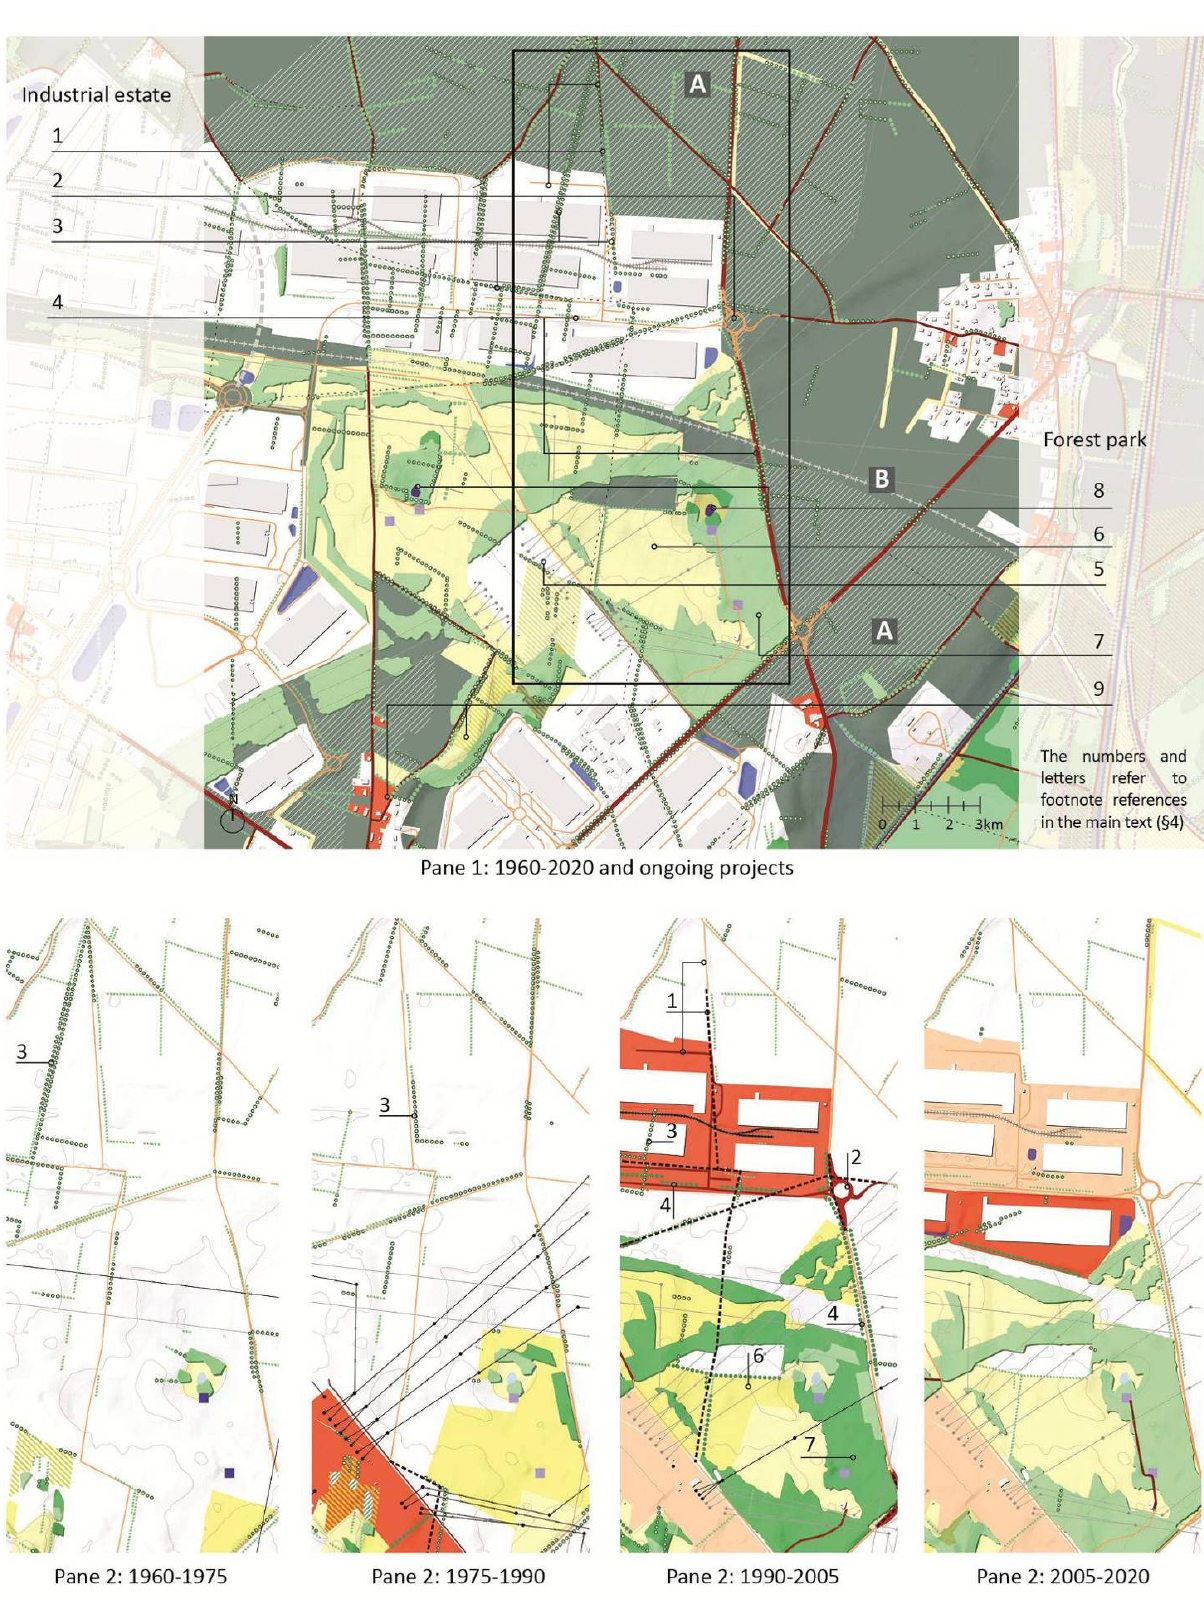
Urban Planning, 2020, Volume 5, Issue 2, Pages